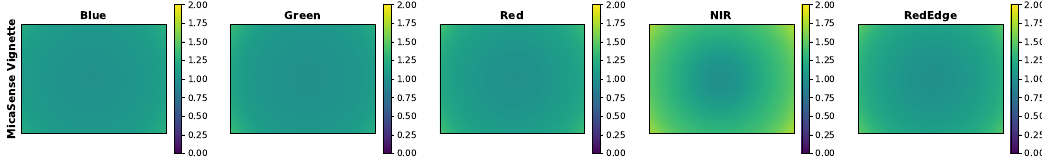
Figure 13. MicaSense vignette imagery. These vignettes are programmed into the particular MicaSense RedEdge-3 sensor used in this study and will never change throughout the lifetime of the sensor.